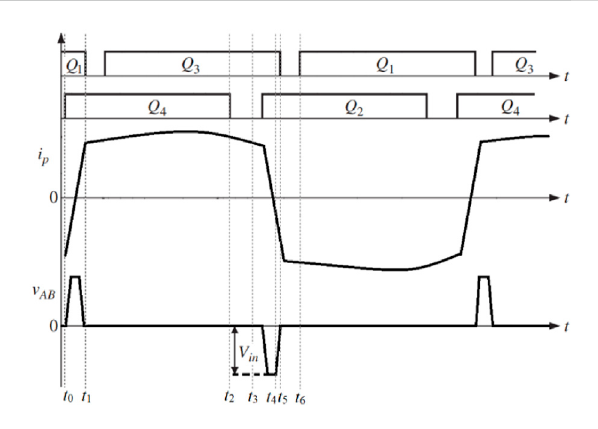
FIGURE 5 Proposed soft-switching circuit. (A) is the topology after adding the current source; (B) is the topology after replacing the current source with an inductor.